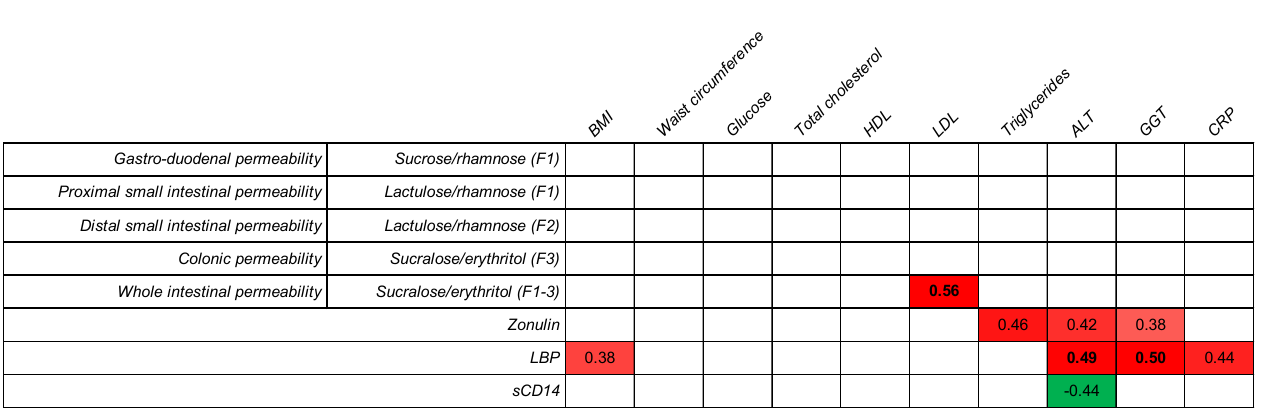
Figure 3. Correlation between metabolic health and gut permeability markers. Pearson’s correlation was performed on the log 10 -transformed values of metabolic health markers and sugar ratios and LGM ( A ) without an acetylsalicylic acid challenge (unchallenged) and ( B ) with an acetylsalicylic acid challenge. Nonbold: correlation is significant at the 0.05 level (2-tailed), bold: correlation is significant at the 0.01 level (2-tailed), and empty cells: no significant correlation. Red indicates a positive correlation (more intense color means a higher correlation), and green indicates a negative correlation.